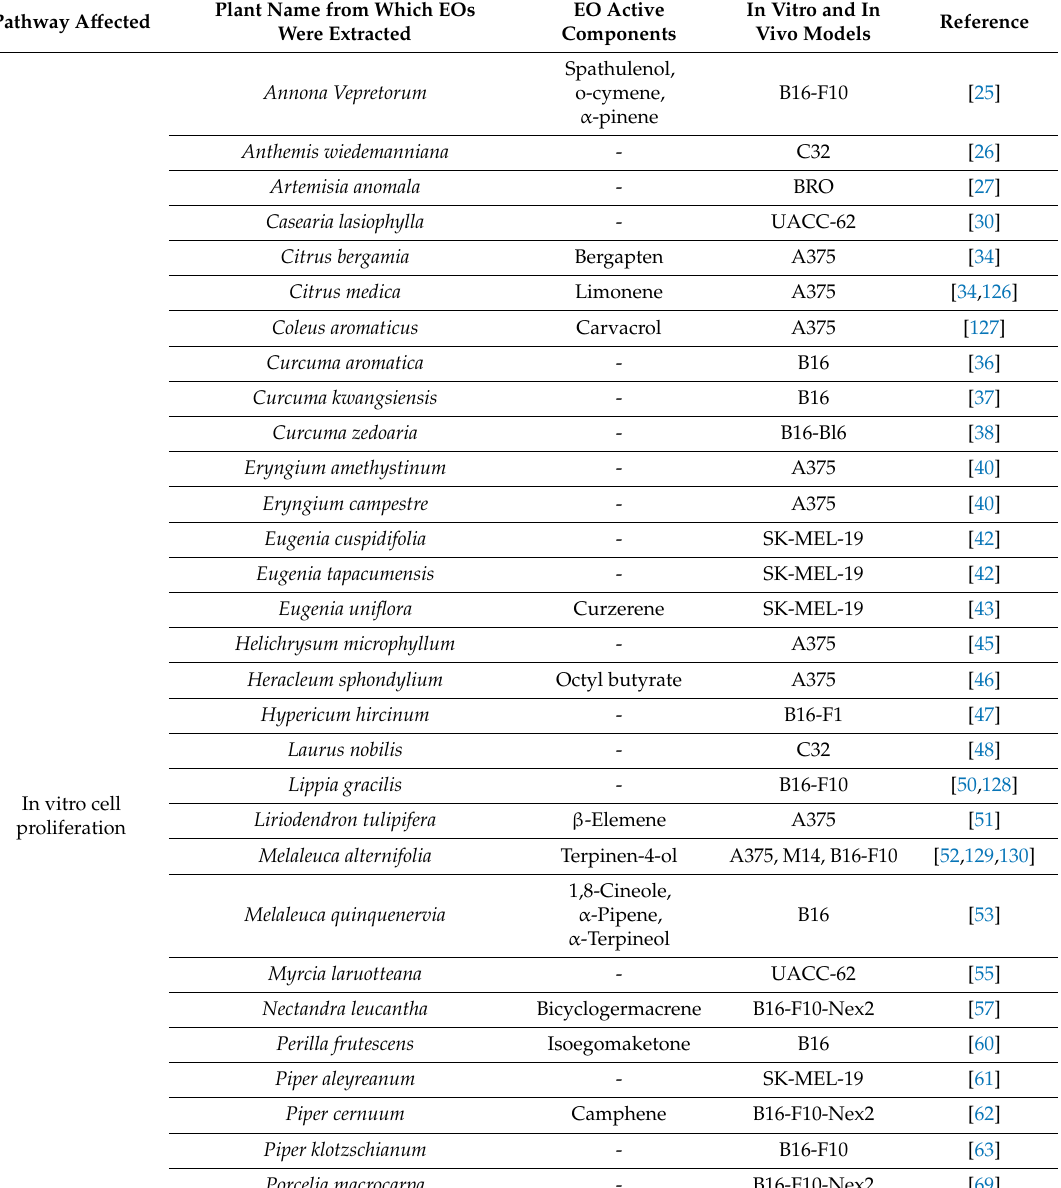
Table 2. EOs and their components that have been demonstrated to a ff ect in vitro or in vivo melanoma growth and